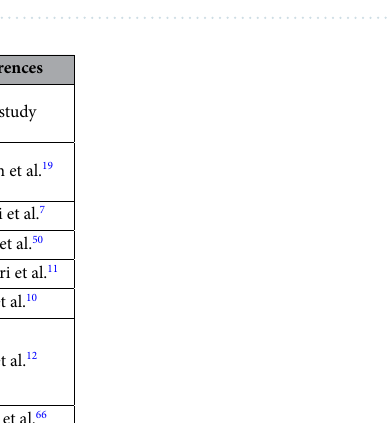
Figure 4. ( a ) Adsorption isotherms, and ( b ) the effect of Cs adsorption reaction time on each activated opaline mudstone.